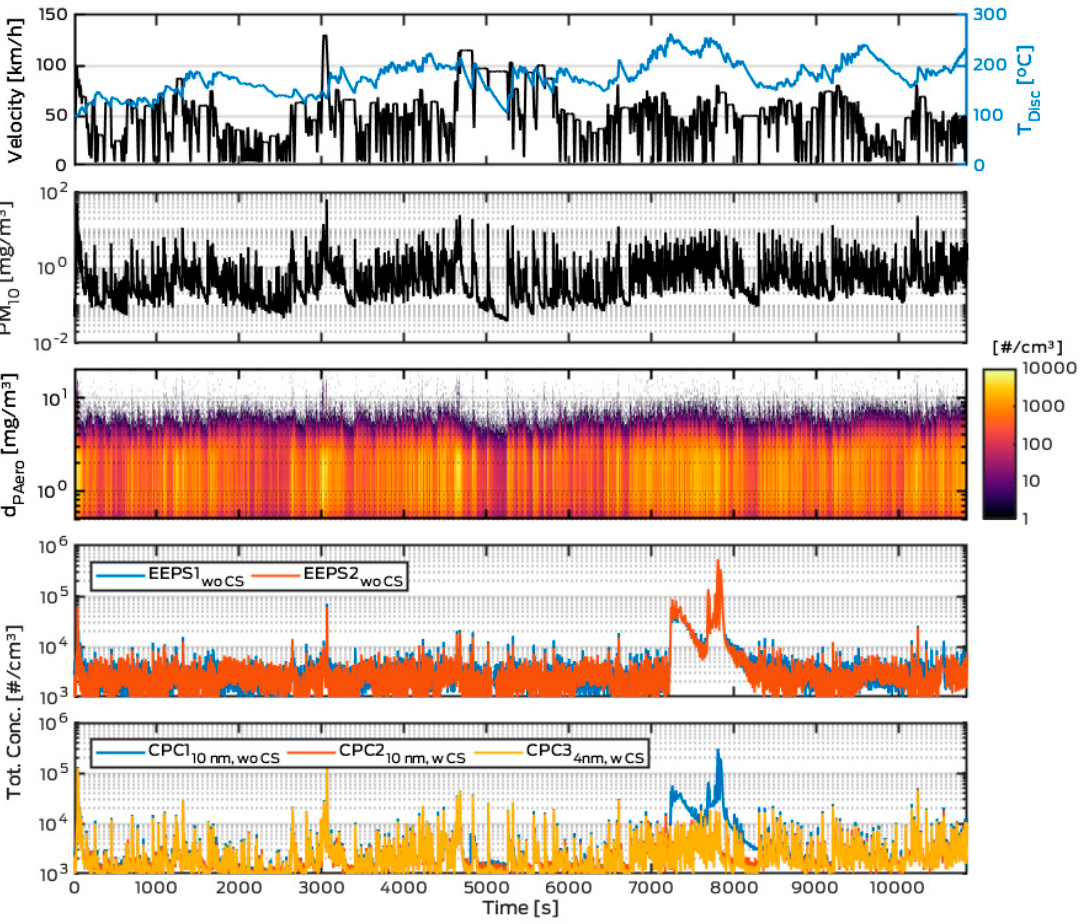
Figure 6. Time trace of second 3h-LACT run. From top to bottom: Vehicle speed and brake disc temperature measured at enclosed wheel. PM concentration as measured by DustTrak. Particle size distribution as measured by APS. Total PN concentration as measured by both EEPS. Total PN concentration as measured by CPCs.